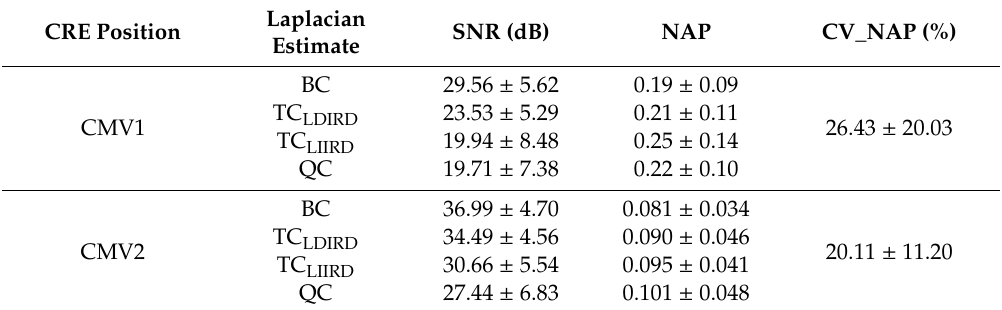
Table 1. Mean ± standard deviation 1 of metrics computed for di ff erent Laplacian estimates (BC, TC LIIRD , TC LDIRD , and QC) at two positions (CMV1 and CMV2). Laplacian CRE Position